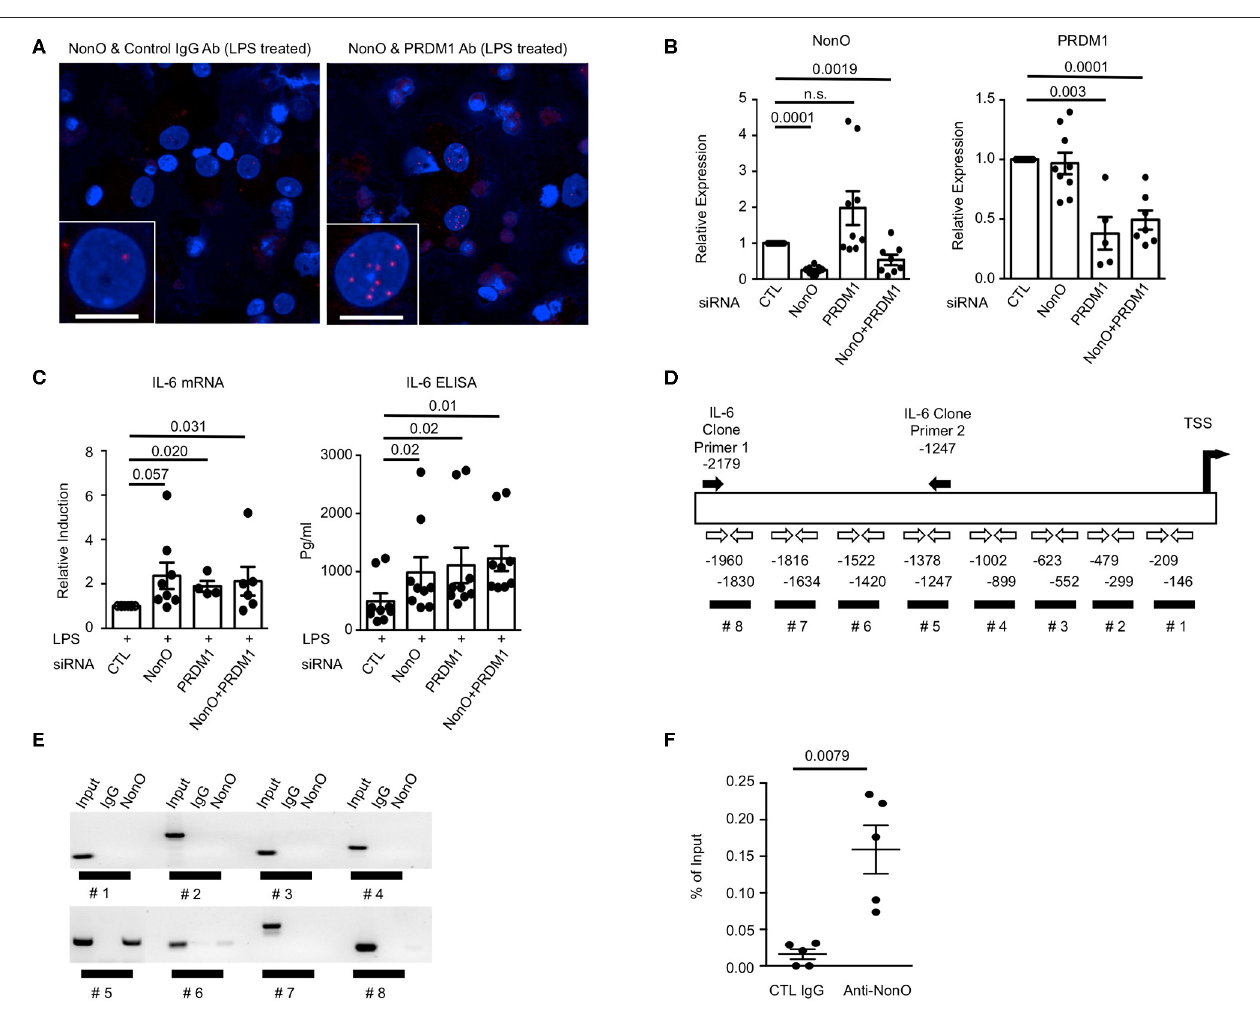
FIGURE 3 | NonO-dependent regulation of IL-6 by PRDM1 in MO-DCs. (A) MO-DCs were stimulated with LPS for 6h and stained with normal rabbit IgG + anti-NonO antibodies (left column) or with anti-PRDM1 antibodies + anti-NonO antibodies (right column). Their proximal interaction was assessed by PLA and visualized as red dots. Nucleus was stained with DAPI (blue). Each Z-Stacks maximum intensity projection image is a representative from three independent experiments and captured 60x magnification. Scale bar = 10 µ m. (B) To knock down NonO, PRDM1, and both (NonO and PRDM1) expression, indicated siRNA or control siRNA was transfected into MO-DCs and NonO and PRDM1 expression level were quantified by qRT-PCR. Bar graph is a mean ± SEM ( n = 9). Significance determined by Man-Whitney test. (C) Indicated siRNA or control siRNA transfected MO-DCs were cultured with or without LPS (1 µ g/ml) for 6h, and total RNA was purified. Level of IL6 was measured by qRT-PCR and relative induction was calculated by normalization to the level of LPS stimulated control. Supernatant concentrations of IL-6 obtained from the cultures were measured using enzyme-linked immunosorbent assay (ELISA). Bar graph is a mean ± SEM ( n = 9). Significance determined by Mann Whitney test. (D) Diagram of human IL6 promoter region with indication of putative PRDM1 binding site (black bar #1–#8) and PCR primers (open arrow). Primer set for IL6 promoter cloning is designated as black arrows. ChIP was performed with anti-NonO antibodies or control IgG from MO-DCs. (E) PCR result was visualized in agarose gel. Binding of NonO to PRDM1 consensus sequences within the IL6 promoter were assessed by each primer set (indicated in C ). (F) To quantify the binding of NonO to #5 region, qPCR was performed and calculated by the percent of input. The graph is a mean ± SEM ( n = 5). Significance determined by Mann Whitney